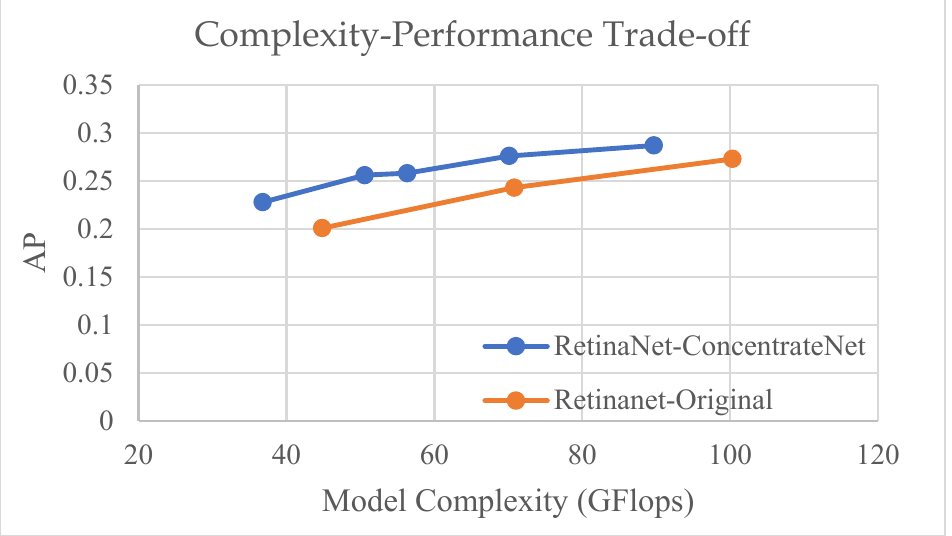
Figure 17. Complexity and performance trade-off comparison. Table 8. The minimum width and AP under different input size.